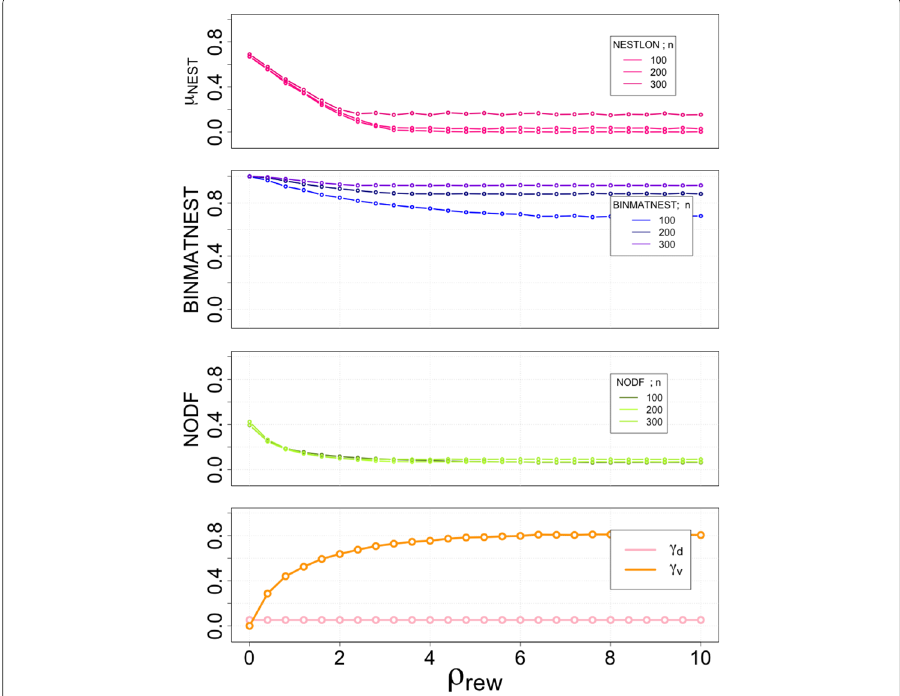
Fig. 4 Robustness analysis for detecting the nested component among BINMATNEST, NODF and NESTLON on a benchmark graph with added noise. With increasing random rewiring ρ rew the nested structure of the benchmark graph dissolves (i.e. increasing violation density γ v ). We perform the computation on a graph of siz e n = 100,200,300 and with α = 0.45 (i.e. γ d ≈ 0.029)